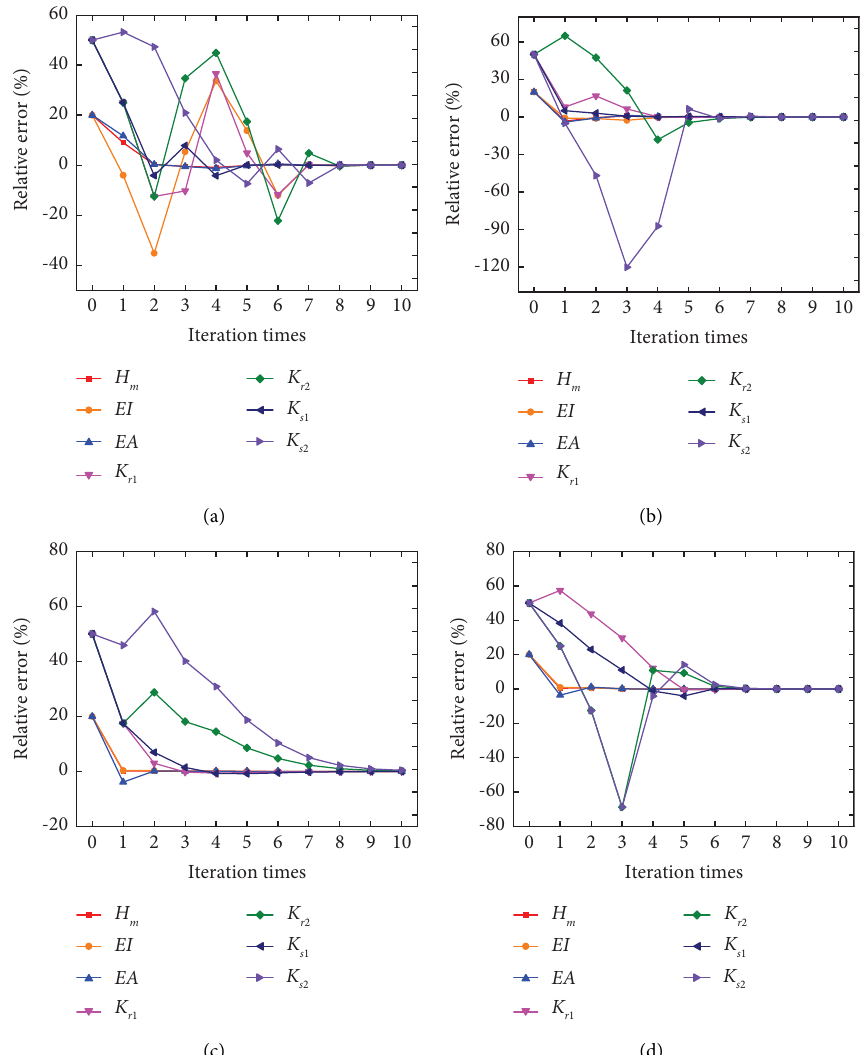
Figure 9: Convergence of the relative errors of cable system parameters with iteration times: (a) Cable 1; (b) Cable 2; (c) Cable 3; and (d) Cable